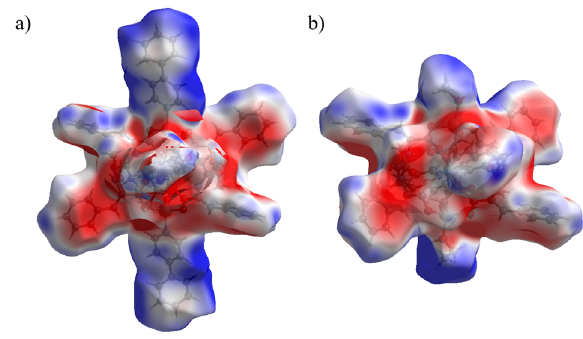
Figure 9. Electrostatic Surface Potential (ESP) surfaces highlighting the electropositive (blue) and electronegative (red) regions over the range ±0.03 au for complexes: ( a ) 2 ·4CH 3 CN and ( b ) 3 ·4EtOH.